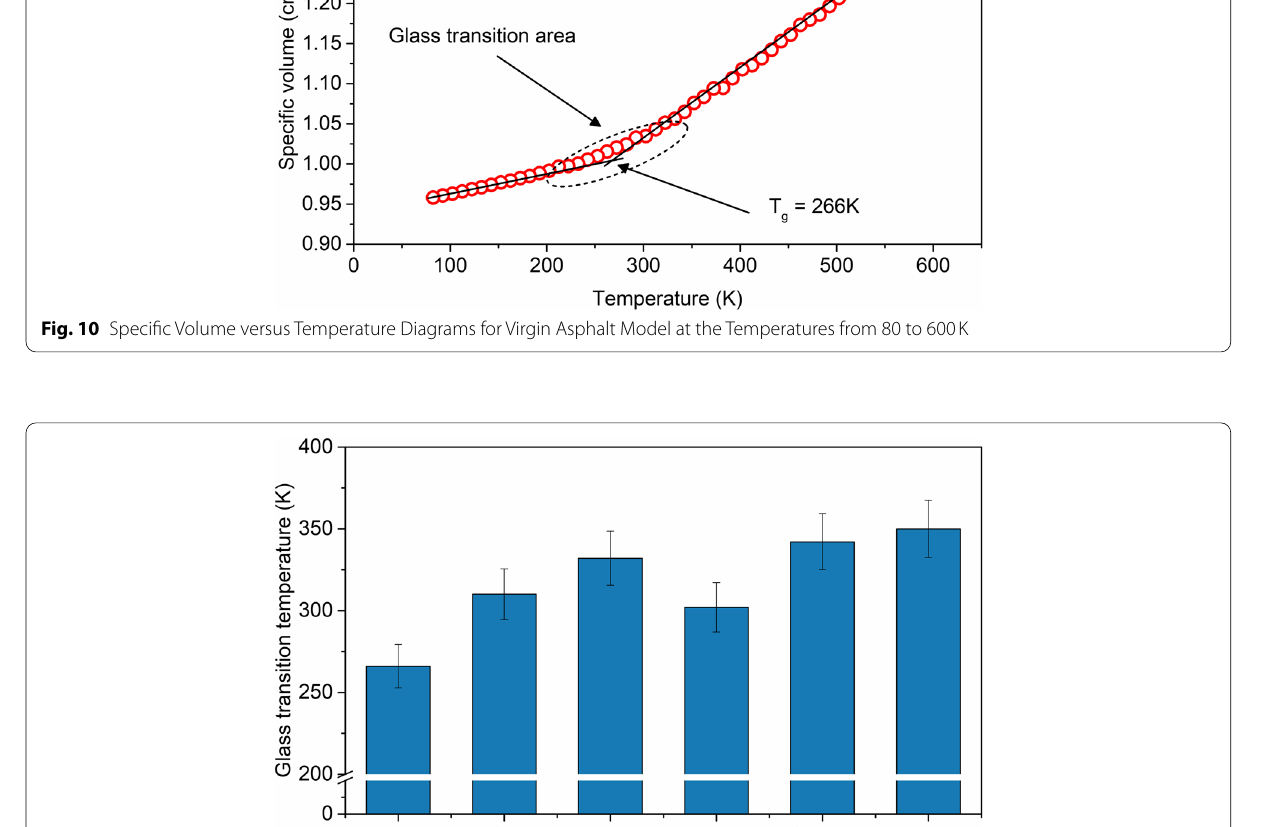
Fig. 11 Glass Transition Temperature of the Asphalt